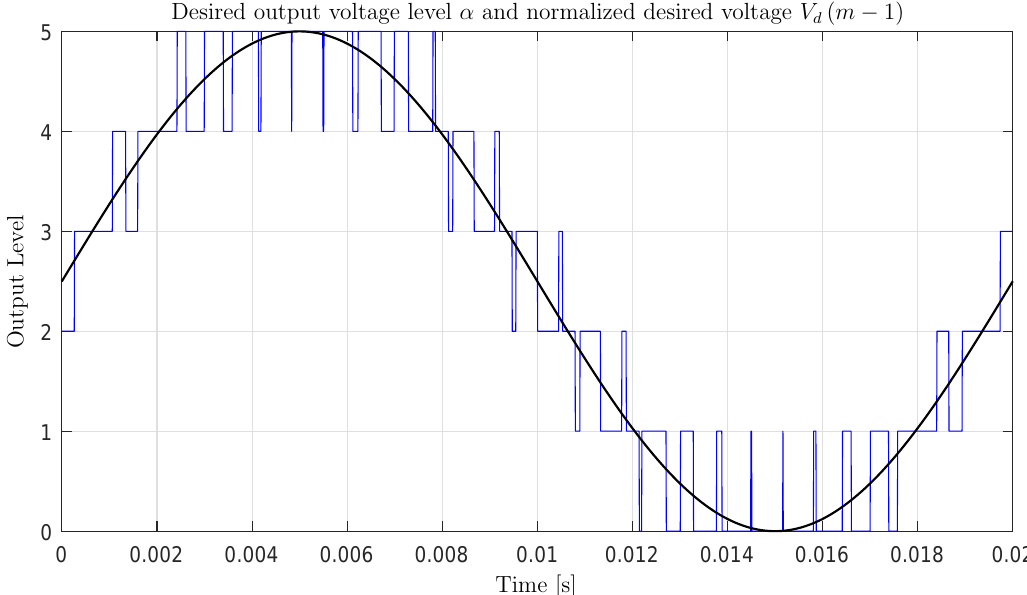
Figure 11. Desired output voltage level α superimposed to normalized desired voltage ˜ V d ( m